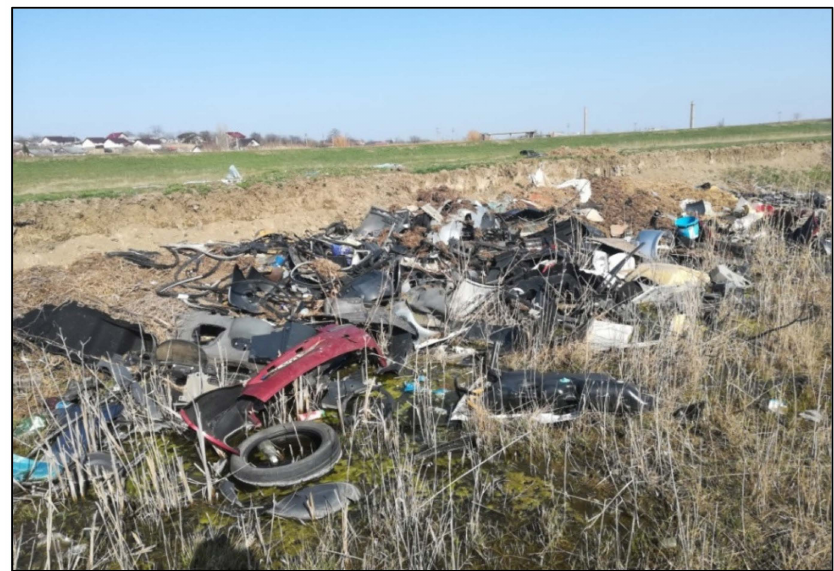
Figure 7. Illegal dumping of ELVs parts on Bahlui floodplain (Hoboca, commune, Iasi County) on 1 April 2021 (Photo: